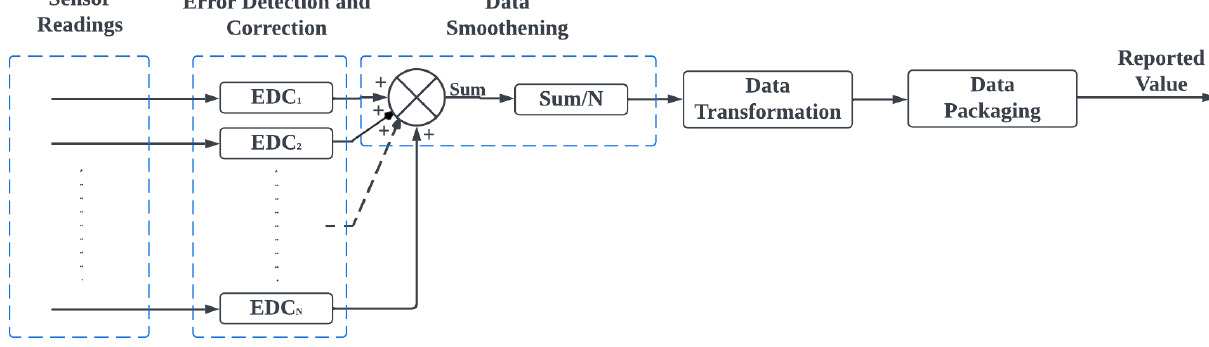
Figure 2. Block diagram of data processing in the perception/sensing layer (PSL). Sensor readings go through error detection and correction to regularize their values, then data smoothening, which involves taking a simple average of the regularized values, followed by data transformation and data packaging, to generate the reported